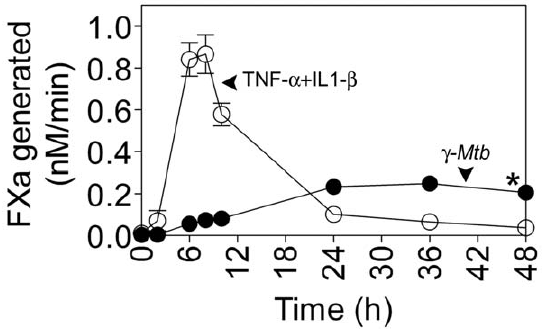
Figure 2. c -Mtb induces TF expression in endothelial cells which follows different kinetics than TNF- a + IL1- b . HUVEC were stimu- lated with TNF- a + IL1- b (20 ng/ml each) (open circles) or c - Mtb H37Rv (10 m g/ml) (closed circles) in EBM-2 complete medium for varying time periods. At the end of the treatment, TF activity on intact monolayers was measured in factor X activation assay. * denotes significant difference from untreated control for all time points (P , 0.001). Data are mean 6 SEM